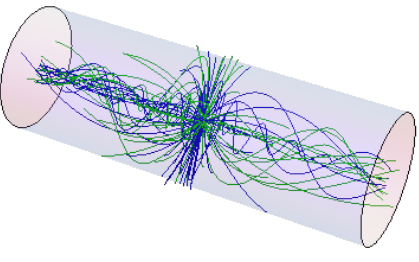
Figure 1. Schematic representation of a soft bomb event with (cid:24) 100 tracks, showing electrons and muons in blue and green respectively. The cylinder represents the inner boundary of the ECAL. An O (1) fraction of the tracks are too soft to reach the ECAL, generating E miss is recoiling against other hard particles in the